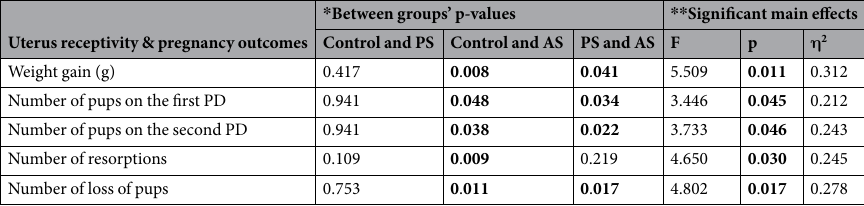
Table 2. Comparison among the three groups in terms of pregnancy outcome and uterus receptivity. AS: auditory stress, PD: postnatal day, PS: physical stress, η 2 = estimate of effect size. * The “between groups’ p-values” show p-values for the between group comparisons, and ** “significant main effects” indicate the statistical results of a significant main effect for every